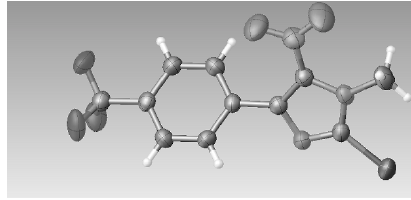
Figure 1. X-ray crystal structure of compound 3c .